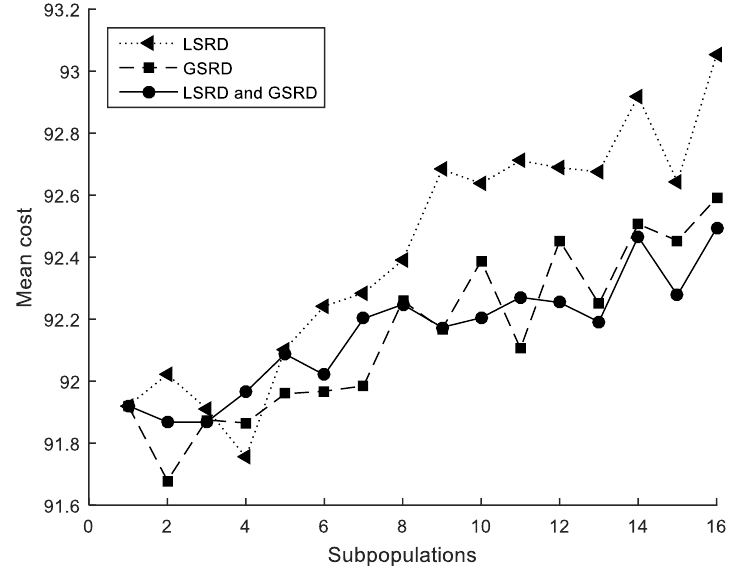
Figure 10. Cross-section under biaxial bending. Mean cost.